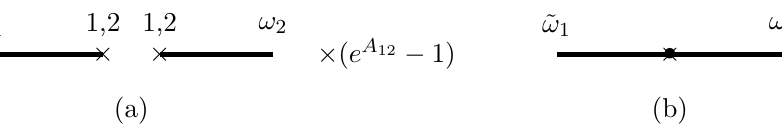
Figure 11 . (a) A Feynman diagram in the open closed string field theory giving two instanton contribution to the closed string two point function. 1,2 label at the vertex means that it can refer to either the first or the second D-instanton. (b) Representation of the same Feynman diagram in closed string effective field theory. •× represents a two instanton interaction vertex in the closed string effective field